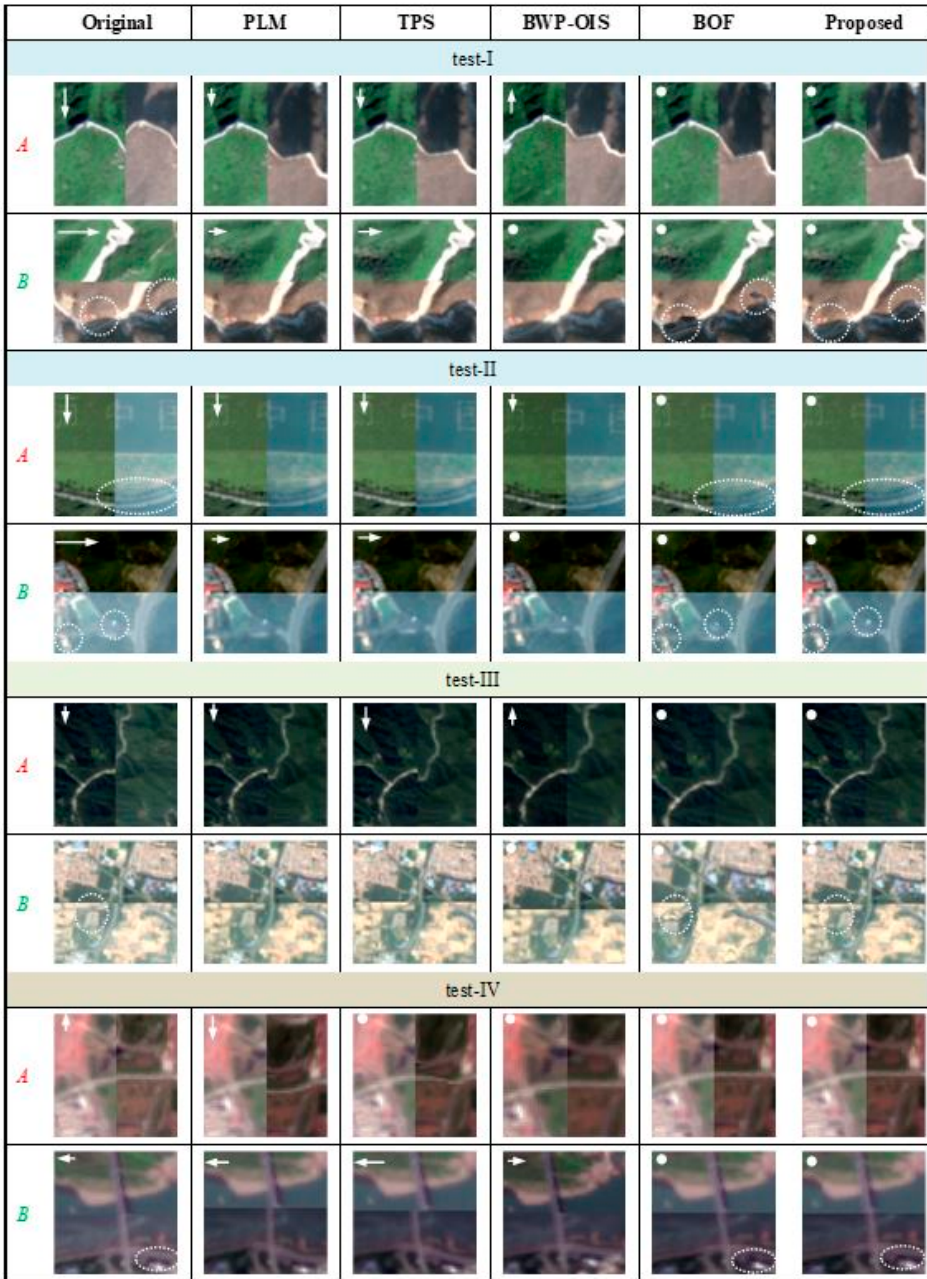
Figure 7. Zoom-in results of red and green dotted-rectangle regions in Figure 6.